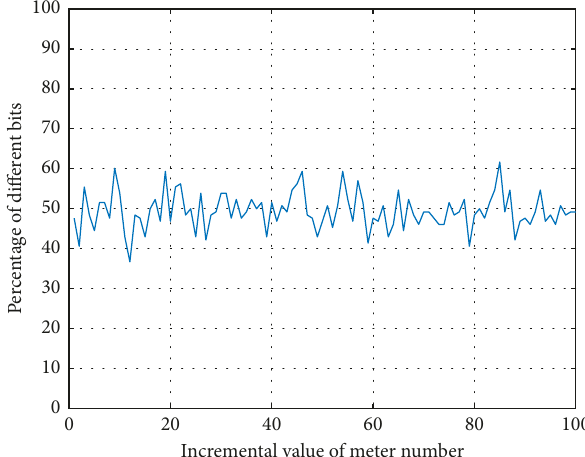
Figure 8: Variation in keys bits as the meter number increases